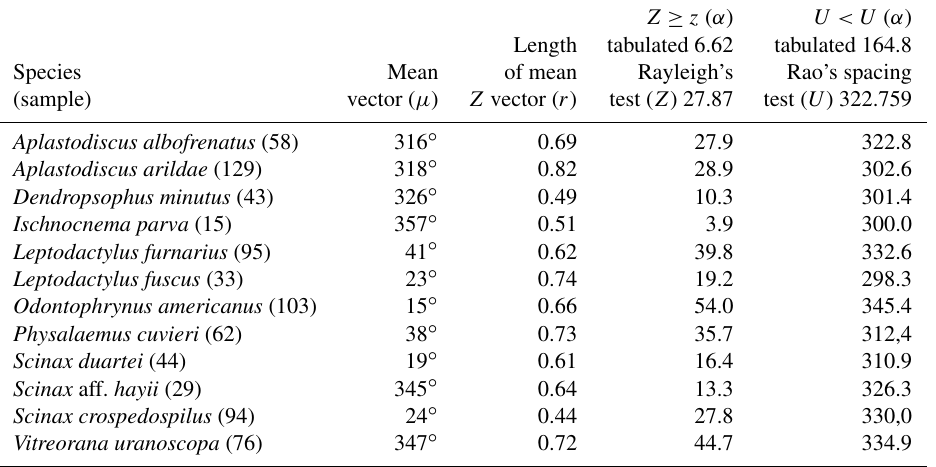
Table 3. Species with non-random unidirectional behavior in quadrant I of the polar axis (315–45 ◦ ) clockwise, under the influence of the synodic cycle between the waning crescent and the waxing crescent (lower albedo); n − 1 degrees of freedom and p = 0 .